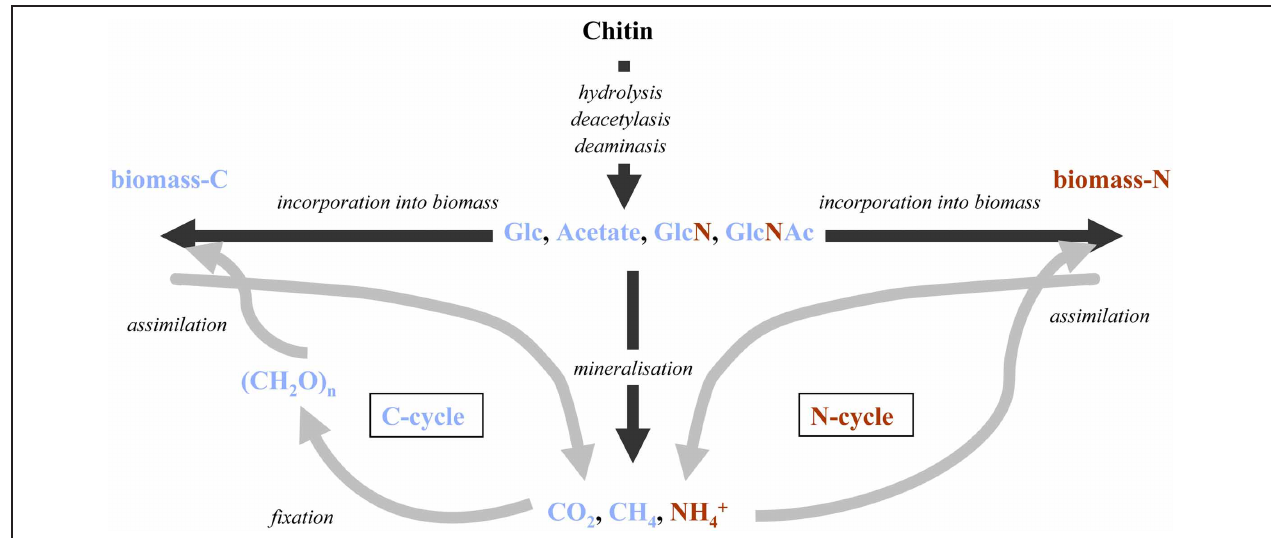
FIGURE 2 | Fate of possible chitin degradation intermediates and degradation products at the interface of the global N and C-cycles: during the first degradation steps chitin is cleaved into small